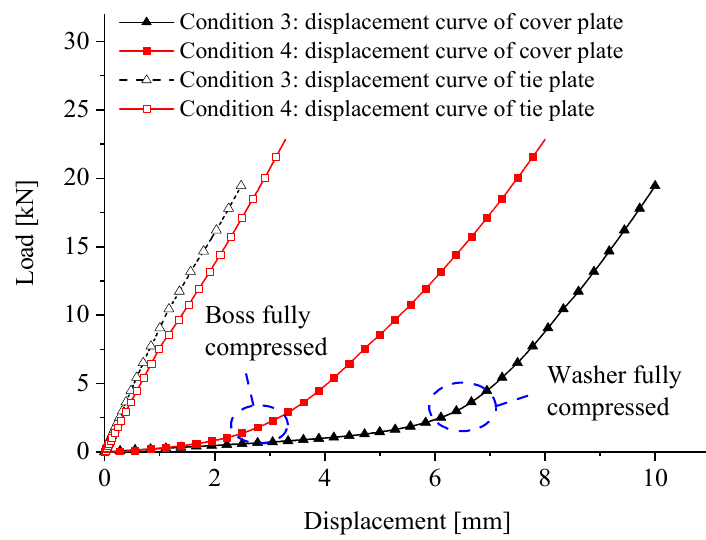
Figure 9. Comparison of stiffness curves.